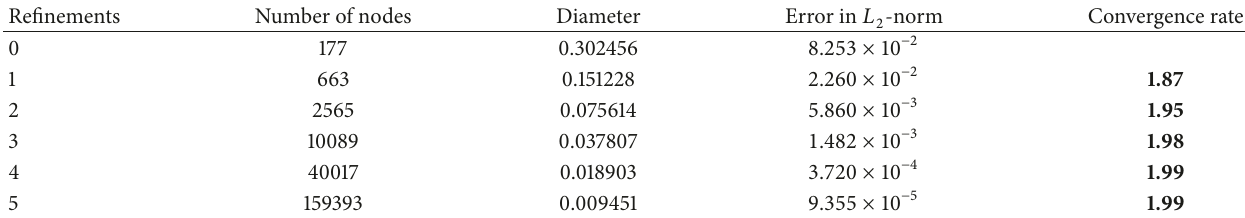
Table 6: Order of convergence in 𝐿 2 -norm for simply supported plate.